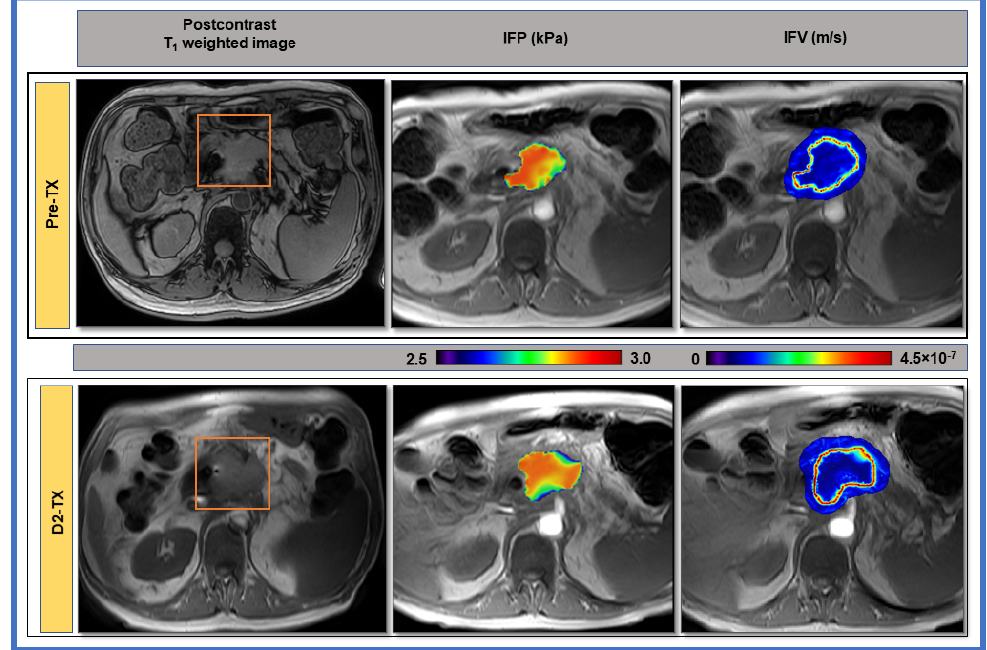
Figure 5. 1st column: Representative pre- and post-stereotactic body radiation therapy (SBRT) T 1 -weighted post-contrast MR images of a patient (63 years, male) with PDAC shown in the body of the pancreas. The red rectangle delineates the region of interest. 2nd column: Computational fluid model estimates of interstitial fluid pressure (IFP). 3rd column: Interstitial fluid velocity (IFV) maps overlaid on pre-contrast T 1 -weighted images from PDAC patients at pre-and post-SBRT (D2-TX). A sharp drop in IFP at the tumor boundary results in evidently high IFV.